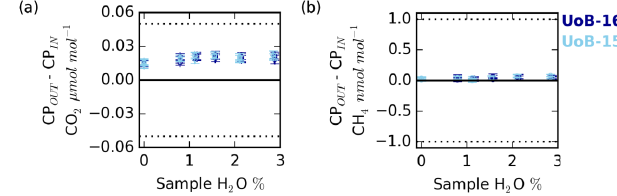
Figure 10. Change in the counter purge in (CP in ) and out (CP out ) (a) CO 2 and (b) CH 4 mole fraction with sample water content for ambient (UoB-15) and above-ambient (UoB-16) mole fraction cylinders. Note that the gas stream was cryogenically dried before analysis. Error bars are the larger of either the standard deviation of the mean difference or the uncertainties of the two sample types added together in quadrature. The dotted lines in (a) and (b) are the respective WMO internal reproducibility